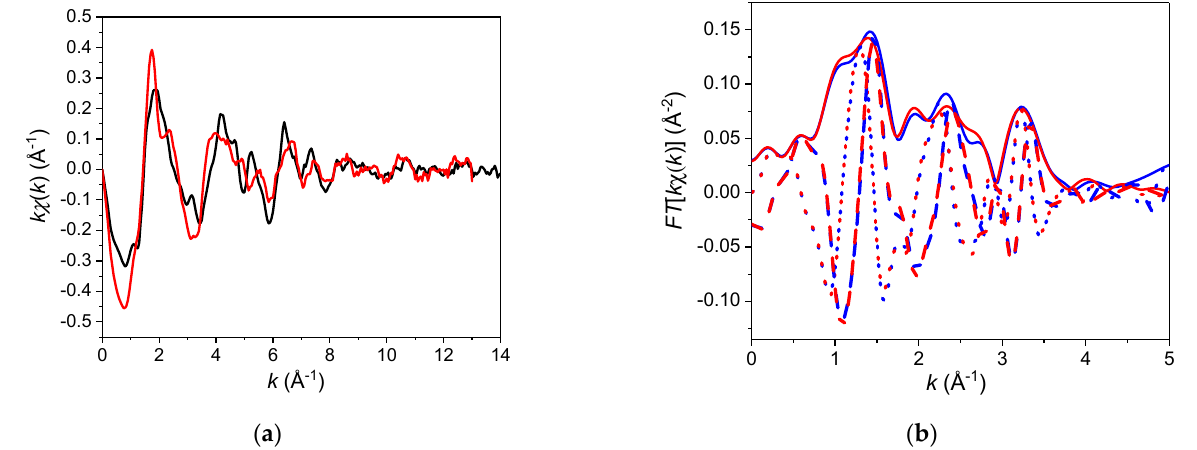
Figure 3. ( a ) Experimental k -weighted (where k is the wavevector) EXAFS signal for the present K 0.985 Mn 0.015 TaO 3 ± δ (red) and previously analysed [29] Sr 0.98 Mn 0.02 TiO 3 (black) ceramics. The latter composition was shown to contain a 0.6:0.4 mixture of Mn 2+ and Mn 4+ residing on the A- and B-sites, respectively. Note the overall similarity between the two signals, with differences accounted for by different backscattering species in the second- and higher-order coordination shells. ( b ) Experimental (blue) and fitted (red) Fourier transform (FT) of the EXAFS signal for K 0.985 Mn 0.015 TaO 3± δ . The magnitude of the FT is shown using solid lines, whereas the real and imaginary parts of the FT are indicated using dashed and dotted lines, respectively. The k range used in the FT was 2.68 Å − 1 to 10.98 Å − 1 . The R factor describing the quality of the fit is 0.0095.